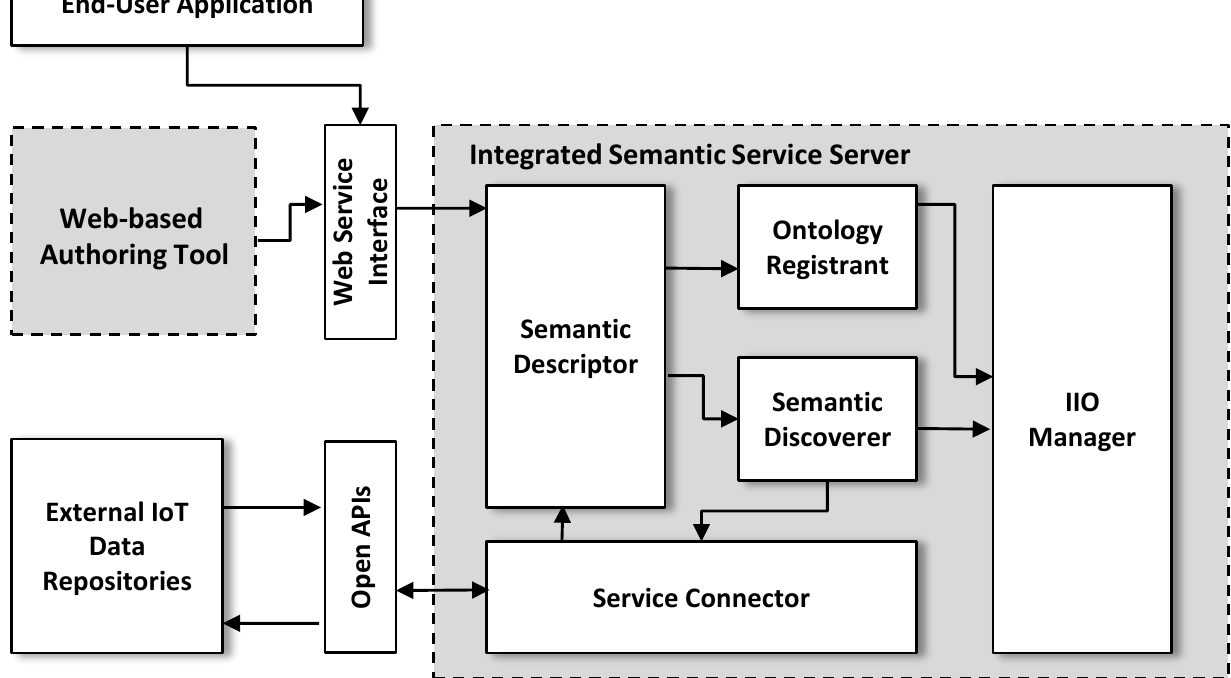
Figure 4. System architecture of the